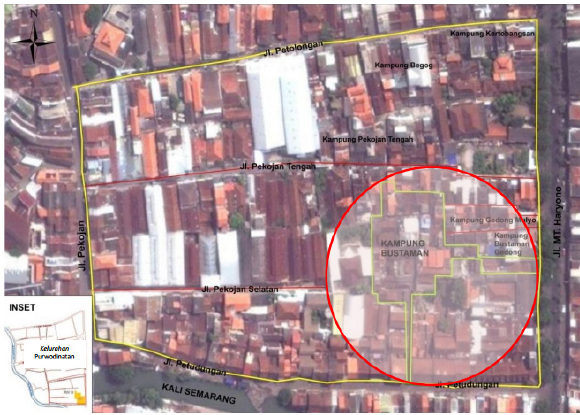
Figure 1. The location of Kampung